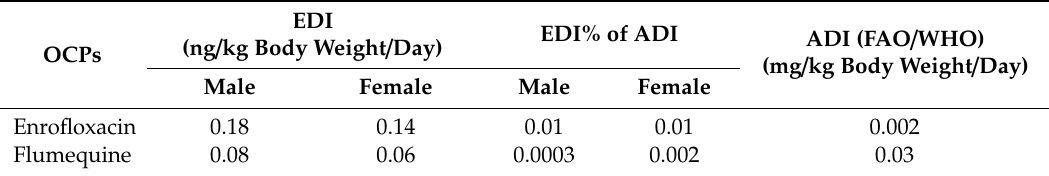
Table 2. Estimated dietary intake of quinolone residues in Taiwanese